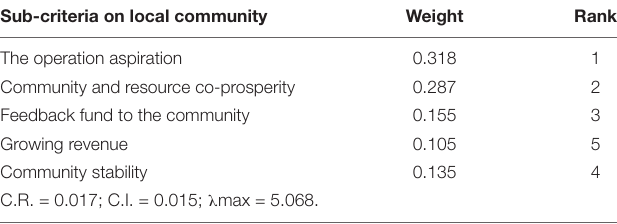
TABLE 6 | Key indicators of local community. Sub-criteria on local community Weight